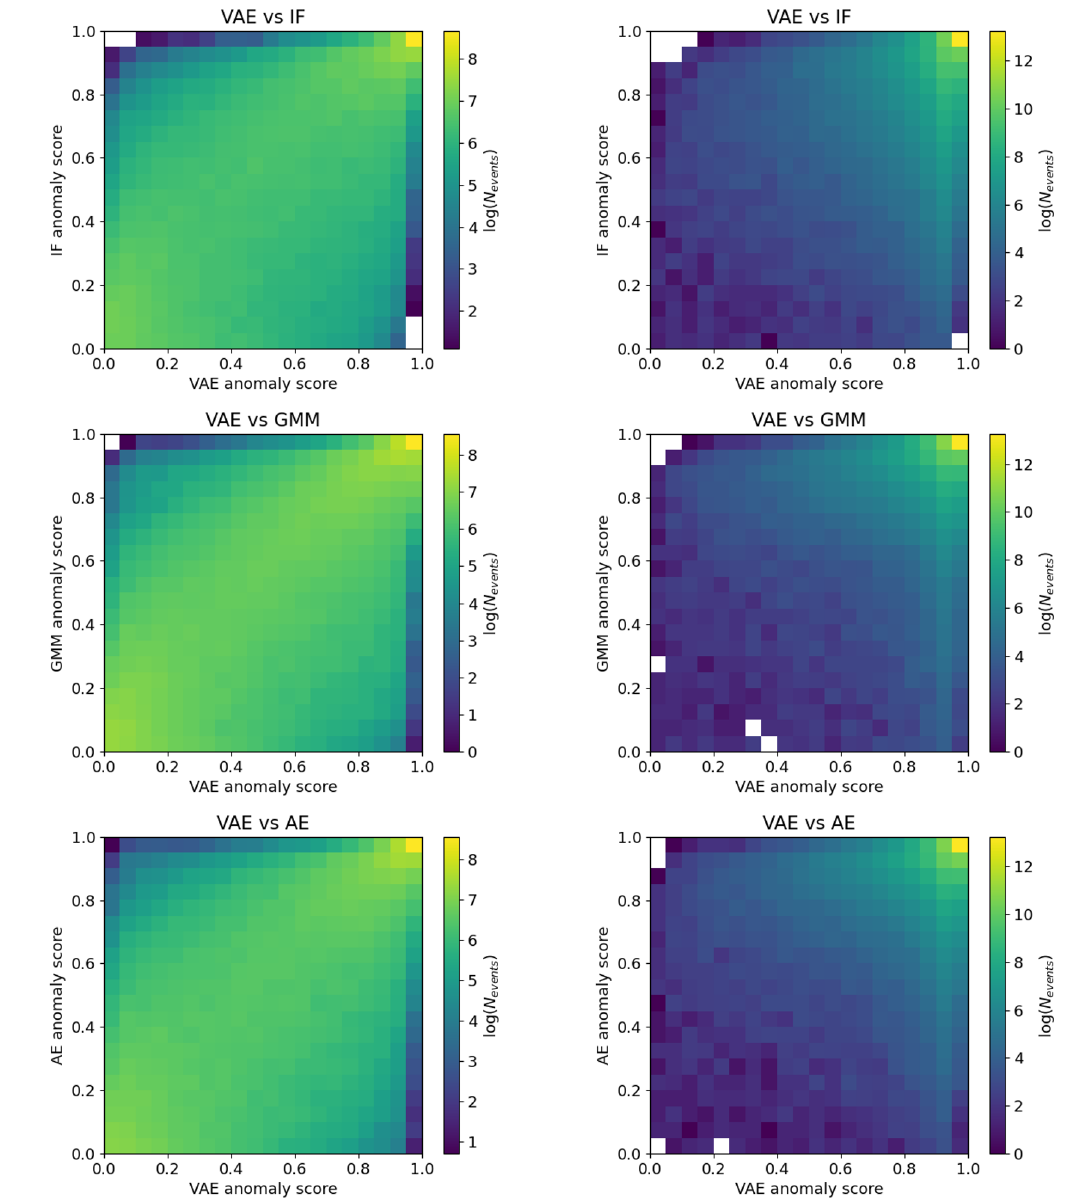
Figure 6 . 2D correlation plots of various anomaly scores with normalised background efficiency compared to the VAE loss for the background (left) and gluino 01 signal (right). The colour coding represents log N events